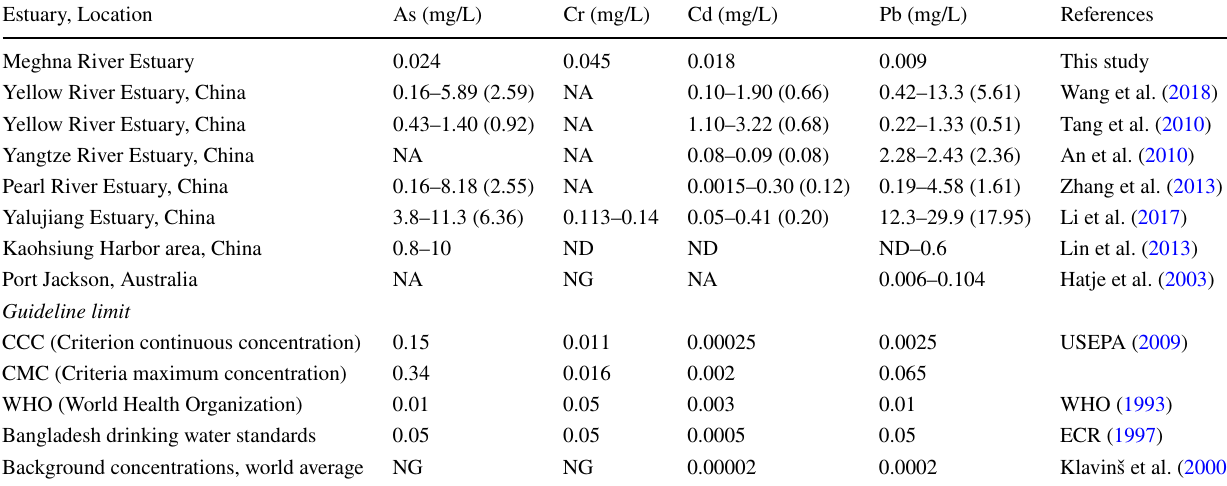
Table 2 A comparison on the concentration of metals studied with that of other study groups Estuary,